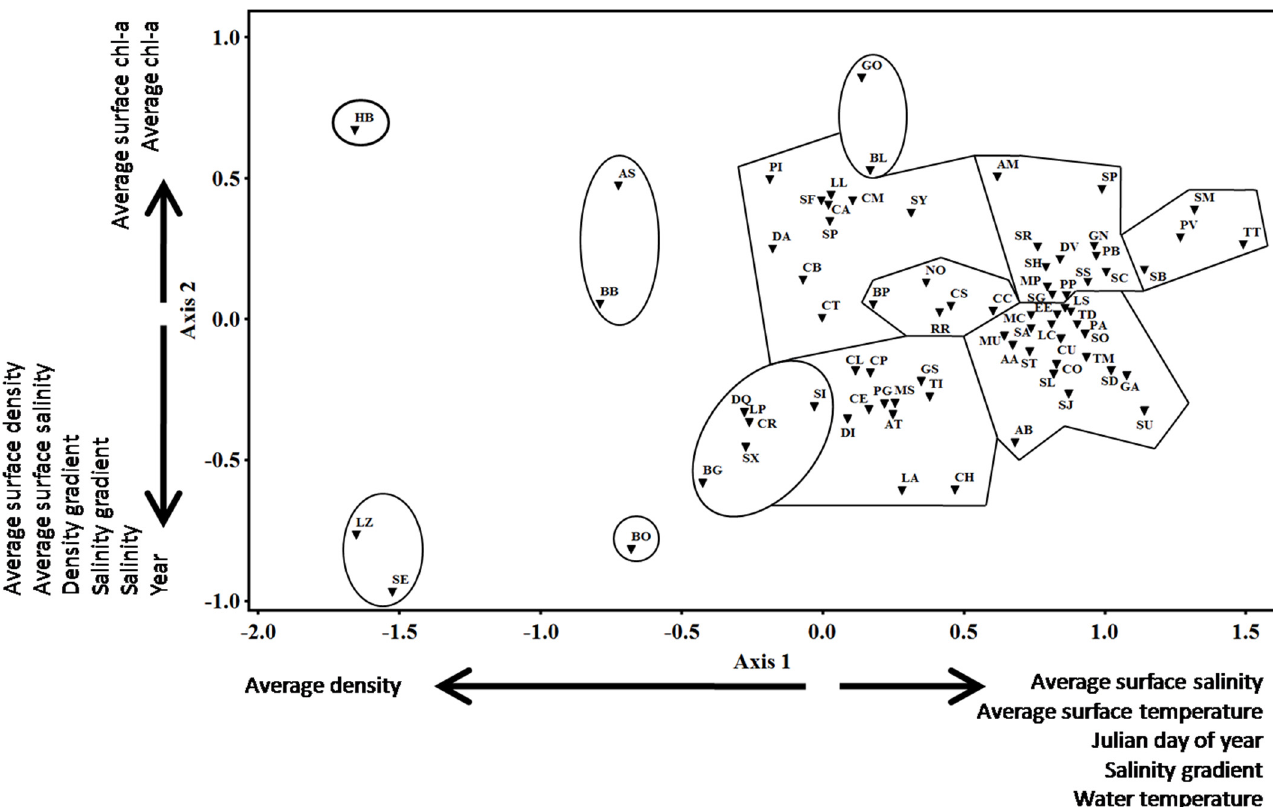
Figure 3. Footnote, species abbreviations for this figure: Anthias anthias , AA ; Aphia minuta , AM ; Arnoglossus spp., AS ; Arnoglossus thori , AT ; Atherina boyeri , AB ; Blennius gattorugine , BG ; Blennius ocellaris , BO ; Blennius pilicornis , BP ; Boops boops , BB ; Buglossidium luteum , BL ; Callanthias ruber , CR ; Callionymus lyra , CL ; Callionymus maculatus , CM ; Callionymus spp., CS ; Centracanthus cirrus , CC ; Cepola macrophthalma , CE ; Cepola rubescens , CU ; Ceratoscopelus maderensis , CA ; Chelon labrosus , CH ; Chromis chromis , CO ; Crenilabrus melops , CP ; Crenilabrus spp., CB ; Deltentosteus quadrimaculatus , DQ ; Diplodus annularis , DA ; Diplodus annularis , DI ; Diplodus vulgaris , DV ; Engraulis encrasicholus , EE ; Gadidae , GA ; Gobiesocidae , GO; Gobius niger , GN ; Gobius spp. II, GS ; Hygophum benoiti , HB ; Lepadogaster candolii , LC ; Lepadogaster lepadogaster , LL ; Lepadogaster purpurea , LP ; Liza aurata , LA ; Liza saliens , LS ; Liza spp., LZ ; Micromesistius poutassou , MP ; Mugil cephalus , MC ; Mugilidae , MU ; Mullus surmuletus , MS ; Notoscopelus , NO ; Pagellus acarne , PA ; Pagellus bogaraveo , PB ; Pagrus pagrus , PP ; Parablennius gattorugine , PG ; Parablennius pilicornis , PI ; Parophidion vassali , PV ; Remora remora , RR ; Sardina pilchardus , SP ; Sardinella aurita , SU ; Scomber japonicus , SJ ; Scorpaena porcus , SO ; Scorpaena scrofa , SC ; Scorpaena spp., SS ; Serranus cabrila , SB ; Serranus hepatus , SH ; Serranus scriba , SR ; Solea lascaris , SL ; Solea spp., SE ; Sparidae , SD ; Sparus aurata , ST ; Spicara flexuosa , SF ; Spicara flexuosa , SX ; Spicara maena , SM ; Spicara smaris , SI ; Spicara spp., SP ; Symphodus cinereus , SY ; Symphurus nigrescens , SG ; Syngnathus acus , SA ; Trachinus draco , TD ; Trachurus mediterraneus , TM ; Trachurus trachurus , TT ; and Trisopterus minutus capelanus , TI